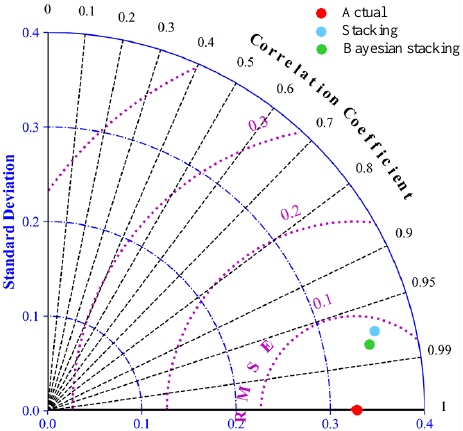
Figure 15. Before and after results of integrated model prediction stacking, according to a Taylor diagram.